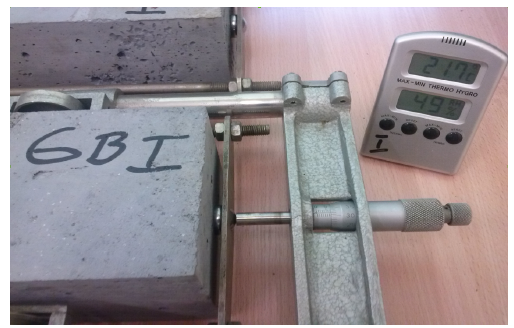
Figure 4. Specimen in Amsler’s apparatus.